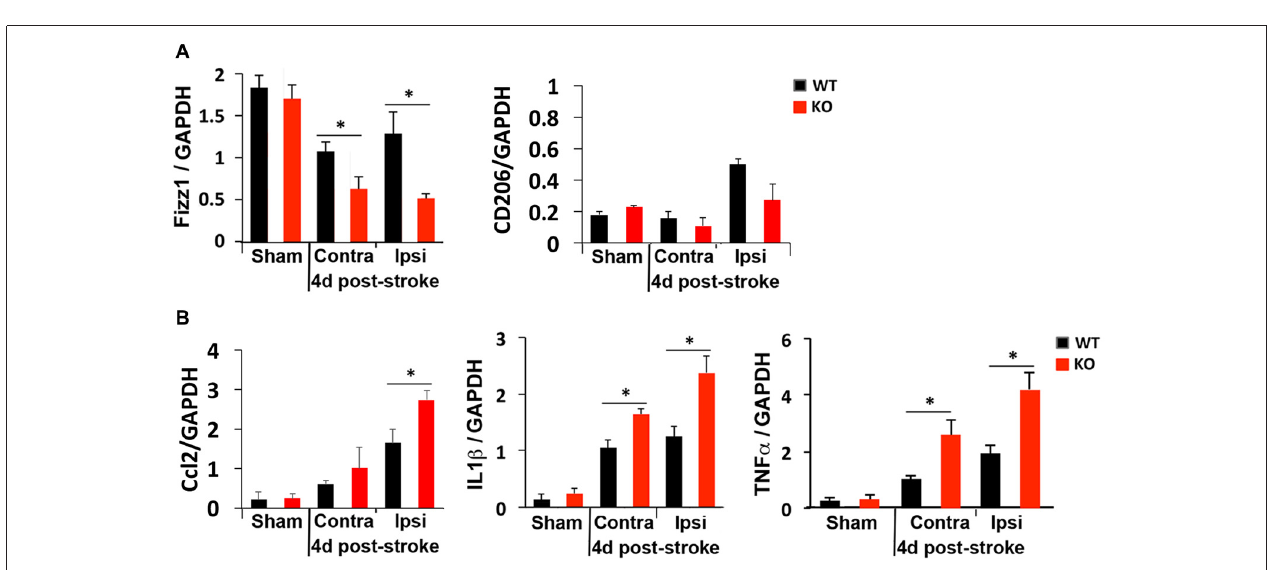
FIGURE 4 | Global elevation of inflammatory cytokines after photothrombosis is worse in KO mice. RT-qPCR revealed (A) reduced levels of the anti-inflammatory gene Fizz1 and (B) elevated levels of the inflammatory cytokines Ccl2, IL1 β and TNF α in both contralateral (Contra) and ipsilateral (Ipsi) sides of KO cortex after ischemic injury. N = 4–5 mice/group. ∗ p <